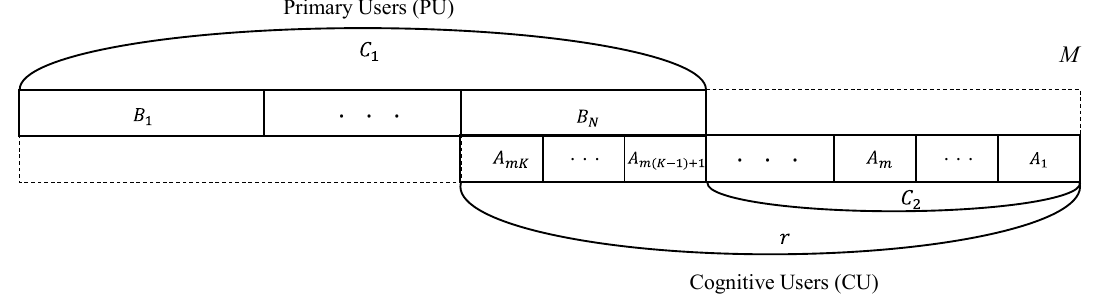
Figure 3. Spectrum band used by two types of radio systems.